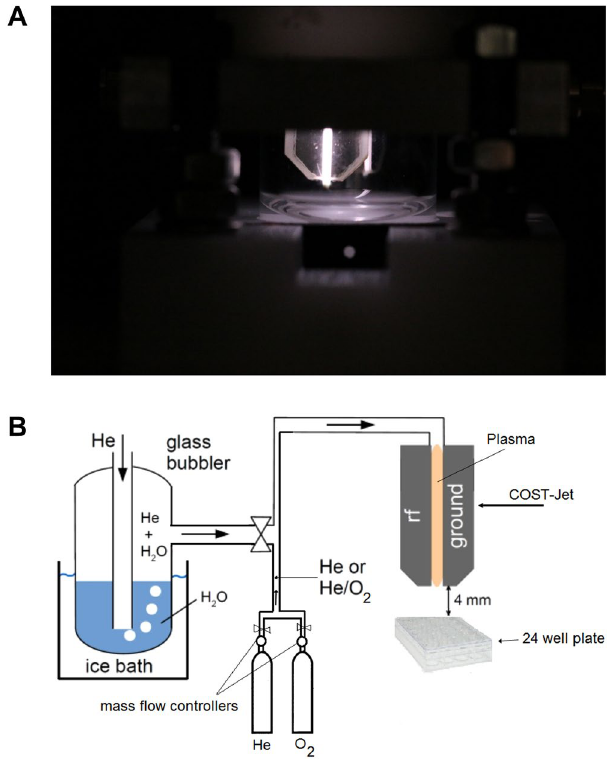
Figure 1. Image of the plasma source and its schematic overview. ( a ) Schematic representation of the plasma source with the bubbler and gas connections. Additionally, one well of a 24 well plate with the relative position of the jet are shown as well. ( b ) Photograph of the atmospheric pressure helium plasma jet ( µ